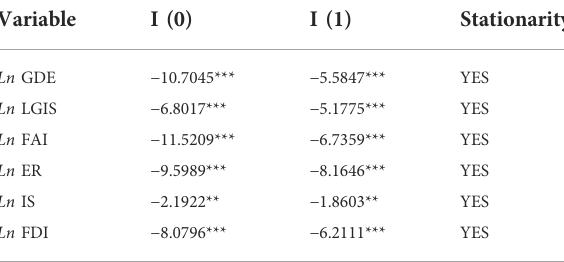
TABLE 4 Panel unit root results: augmented dickey-fuller (ADF) test. Variable I